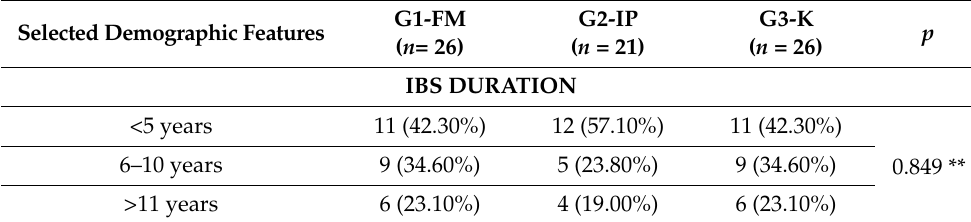
Table 1. Cont. Selected Demographic